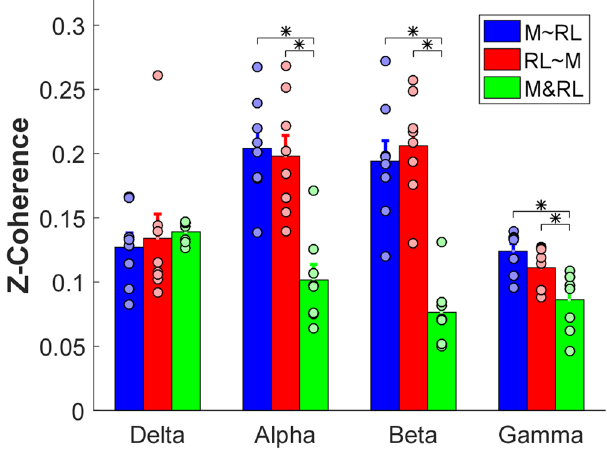
Figure 6. Overall comparisons across two partial residuals and cross-compartment coherence in the middle vs. ring-little combination. Each bar represents the average magnitude of z-coherence, and the error bars represent standard errors. Asterisks indicate statistical significance. The black circles represent values of individual subjects. Different colors represent the different types of coherence.